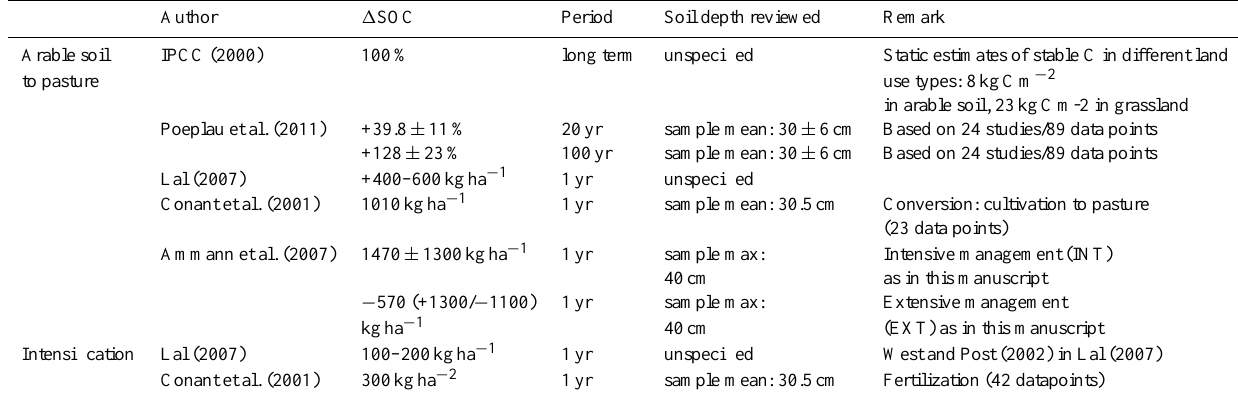
Table 1. Literature estimates of 1 SOC with land use conversions from arable to pasture or management intensification in terms of manure applications and ploughing